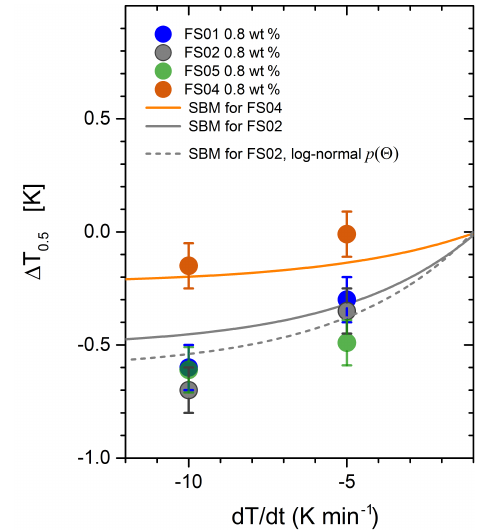
Figure 8. The shift (cid:49)T 0 . 5 of the median temperature T 0 . 5 relative to the T 0 . 5 at 1Kmin − 1 for different cooling rates c = d T/ d t . Solid lines represent expected (cid:49)T 0 . 5 (c) calculated with fit parameters given in Table 2. Dashed line is the theoretical temperature shift calculated with the same SBM parameters for FS02 but assuming the log-normal distribution of contact angles p(θ)